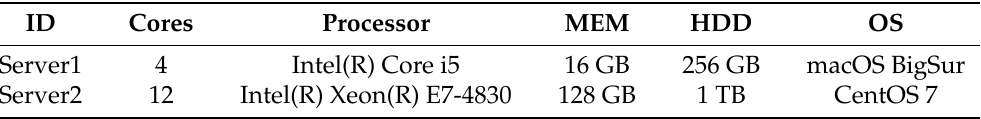
Table 1. IT Infrastructure used in the